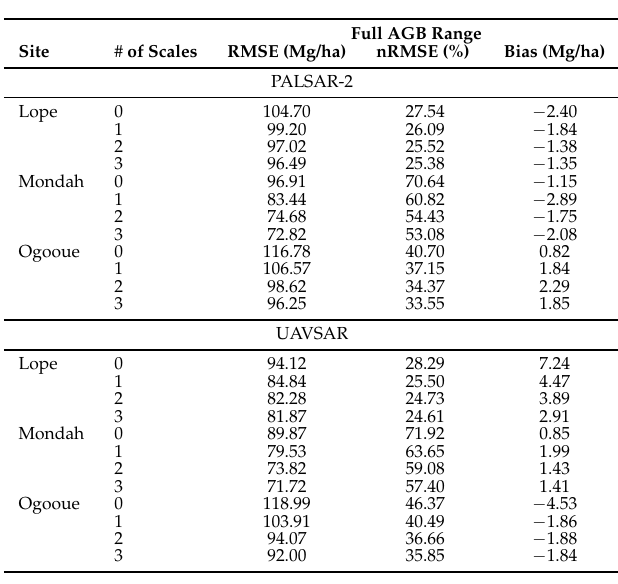
Table 5. Below, we add various Felzenswalb superpixel segments as features into the RF model. The # of scales indicates the number of superpixel segments used to generate features. No scales indicates only pixelwise features are